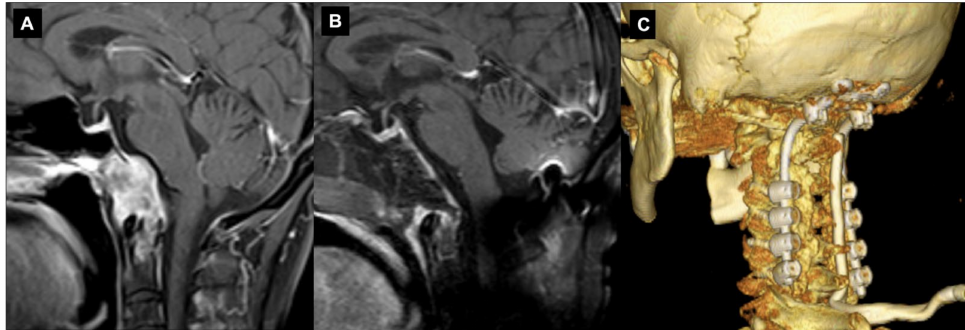
Figure 5. Endoscopic endonasal approach to CVJ chordoma and occipitocervical fixation. Sagittal preoperative ( A ) and postoperative ( B ) T1-weighted MR images after contrast injection showing